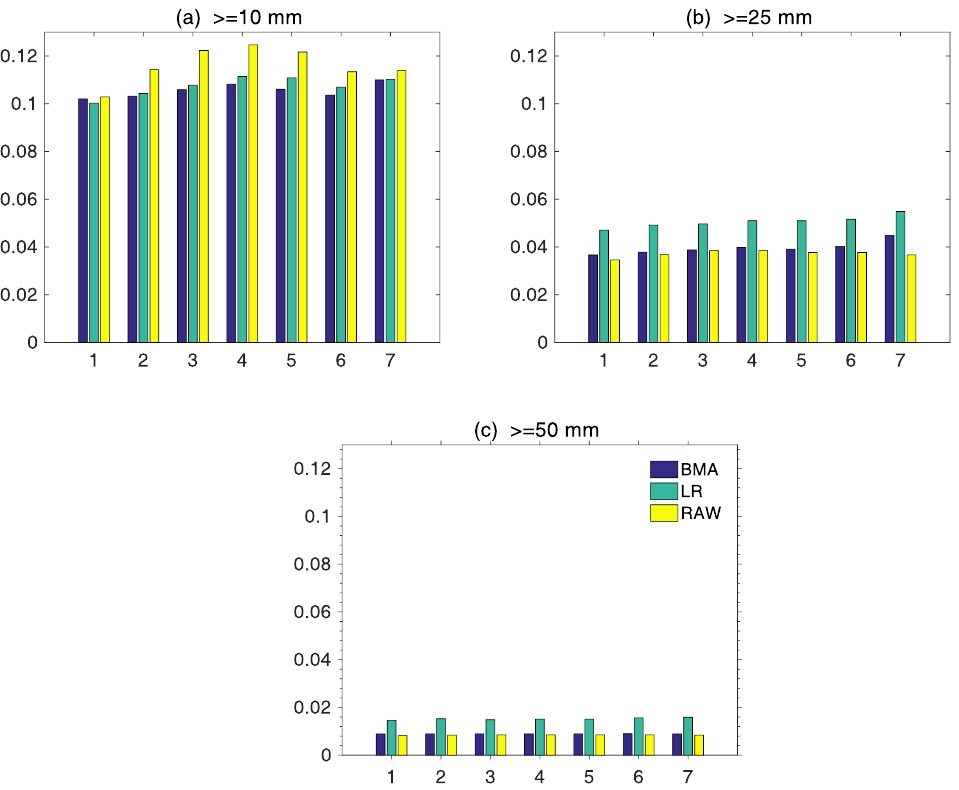
Figure 3. The Brier scores of the probabilistic forecasts of 24 h accumulated precipitation exceeding the thresholds of 10 ( a ), 25 ( b ), 50 ( c ) mm with lead times of 1–7 days from Bayesian model average (BMA), logistic recession (LR), and raw ensemble prediction system forecasts (RAW).